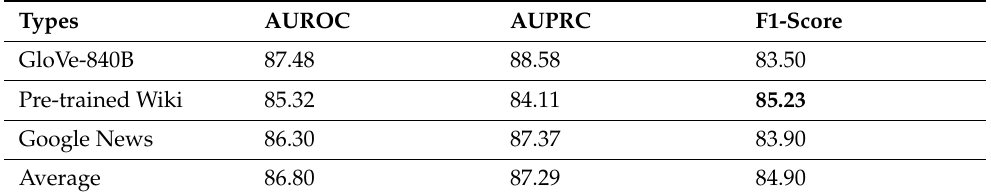
Table 4. Performance analysis of pre-trained-word embedding.